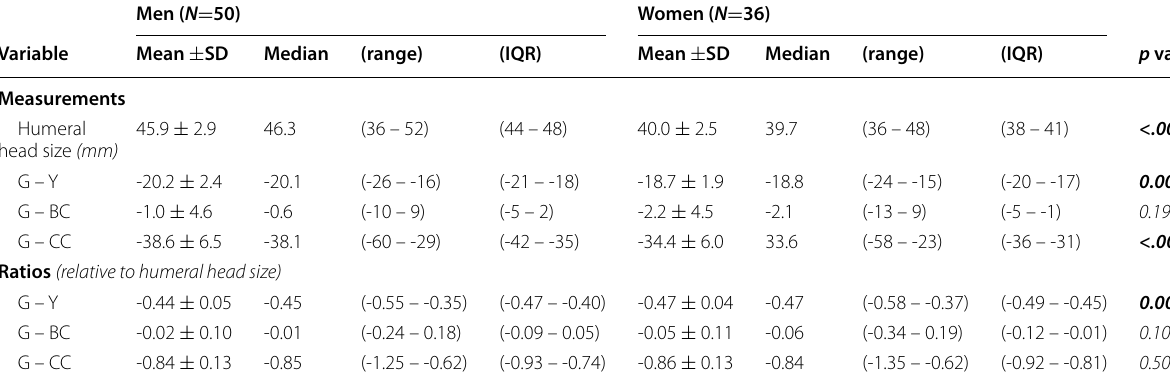
Positive values indicated that points were lateral to the glenoid, whereas negative values indicated that points were medial to the glenoid